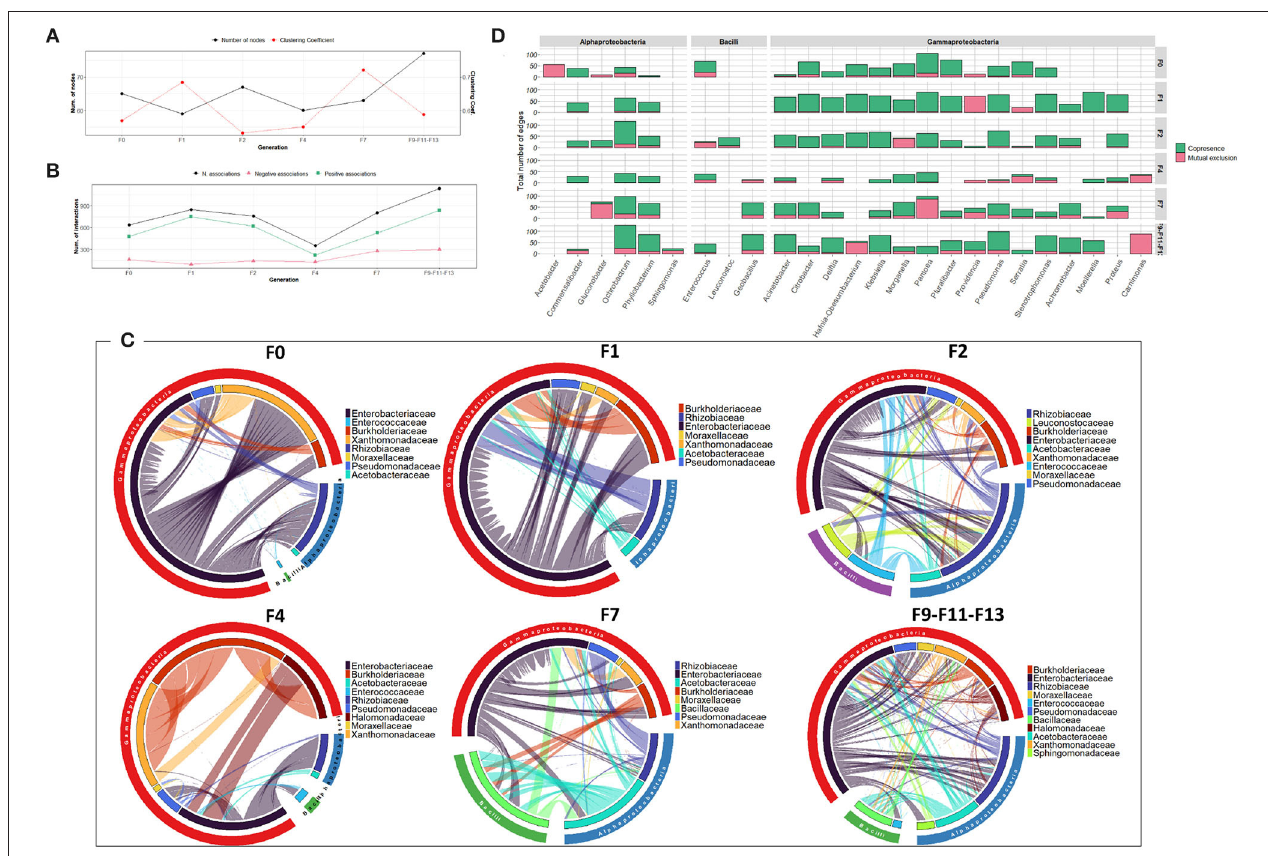
FIGURE 5 | Bacterial community network within the guts of C. capitata larva during laboratory adaptation of wild population. (A) Total number of nodes and clustering coefficient. (B) Total number of negative (red) and positive (green) associations. (C) Chord diagram displaying direct relationship between OTUs at family level. The size of the ribbon is proportional to the weight of the association between the OTUs assigned to the respective segments and the color of the ribbon present in the direction of the interaction. (D) Number of positive and negative associations at the genus